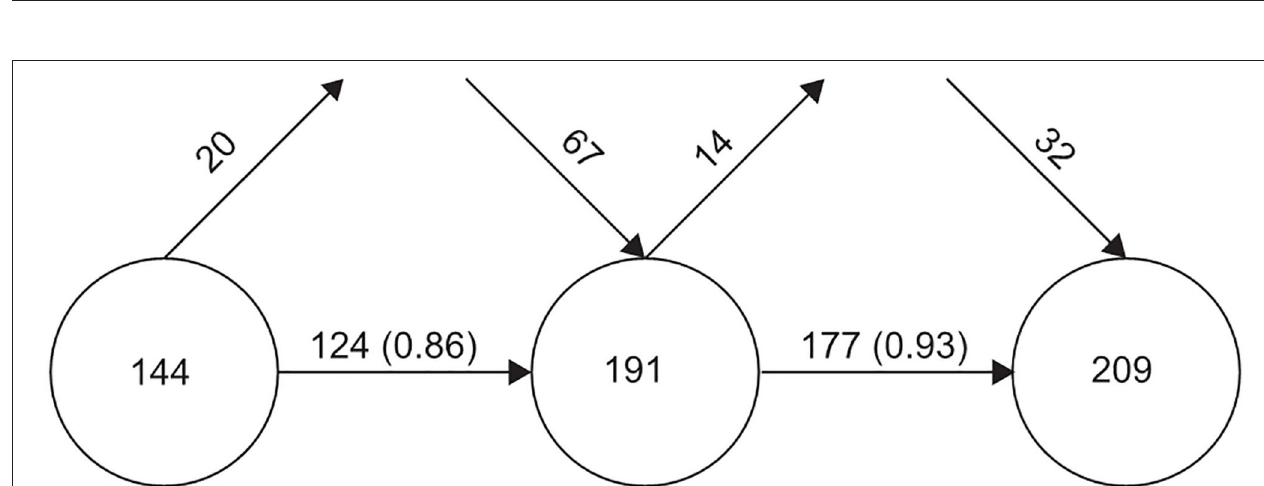
FIGURE 5 | Network structure with high co-occurrence frequency of highly cited papers.